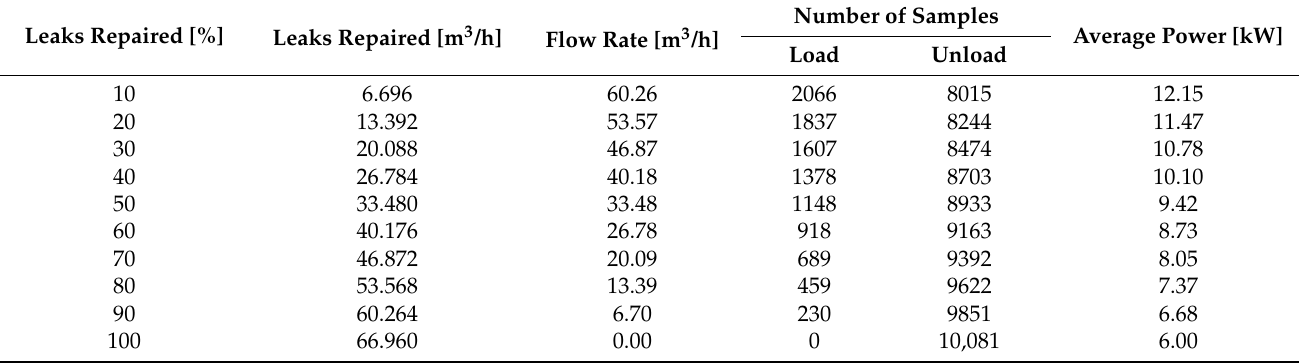
Table 8. Average air compressor power after the leaks repair during the no compressed air consump- tion